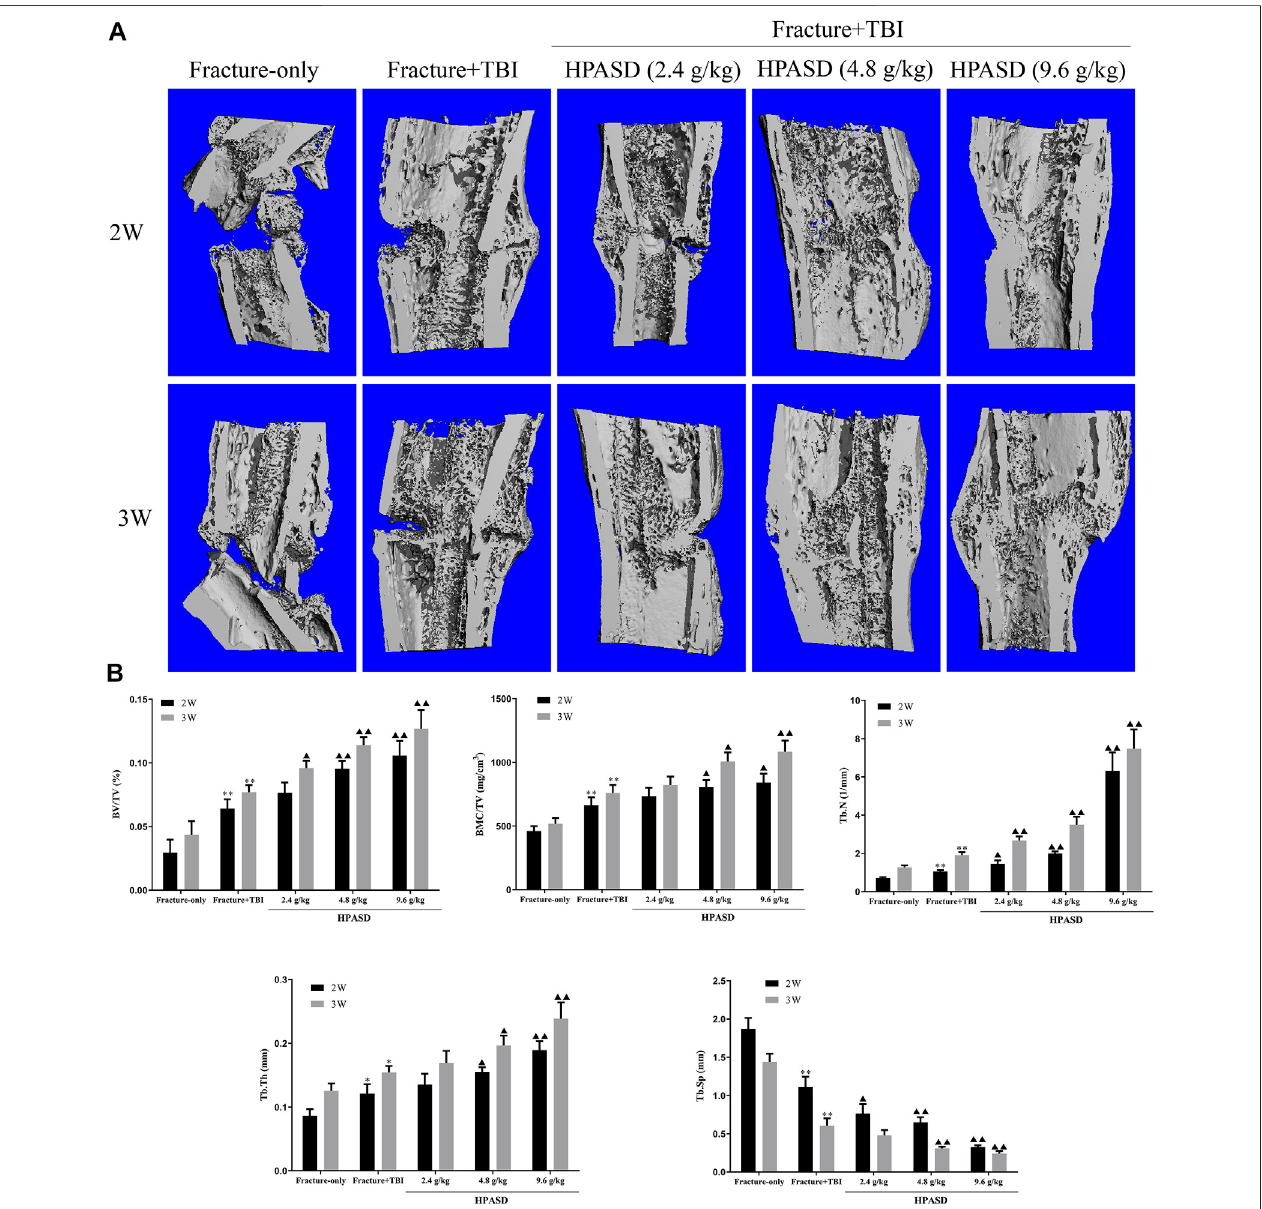
FIGURE 4 | HPASD promoted the formulation of fracture callus in the rat model of traumatic brain injury. (A) Longitudinal cut view of Region Of Interest (ROI) in fracture site was displayed by Micro-CT analysis. (B) Quantitative analysis of BV/TV, BMC/TV, Tb. N, Tb. Tn, and Tb. Sp in ROI at the second and third weeks after HPASD treatment. Values are mean ± SD. * p < 0.05 , ** p < 0.01 vs. Fracture-only group; ▲ p < 0.05 , ▲▲ p < 0.01 vs. Fracture + TBI group [ ANOVA ].